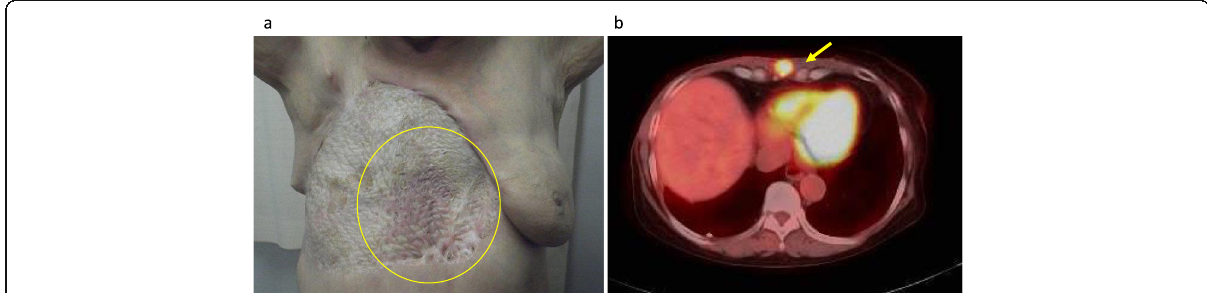
Fig. 2 One year after breast surgery, the following two recurrences appeared: a Local recurrence of the skin graft (circled) and b Intramuscular metastatic tumor near the xiphoid process (indicated by an